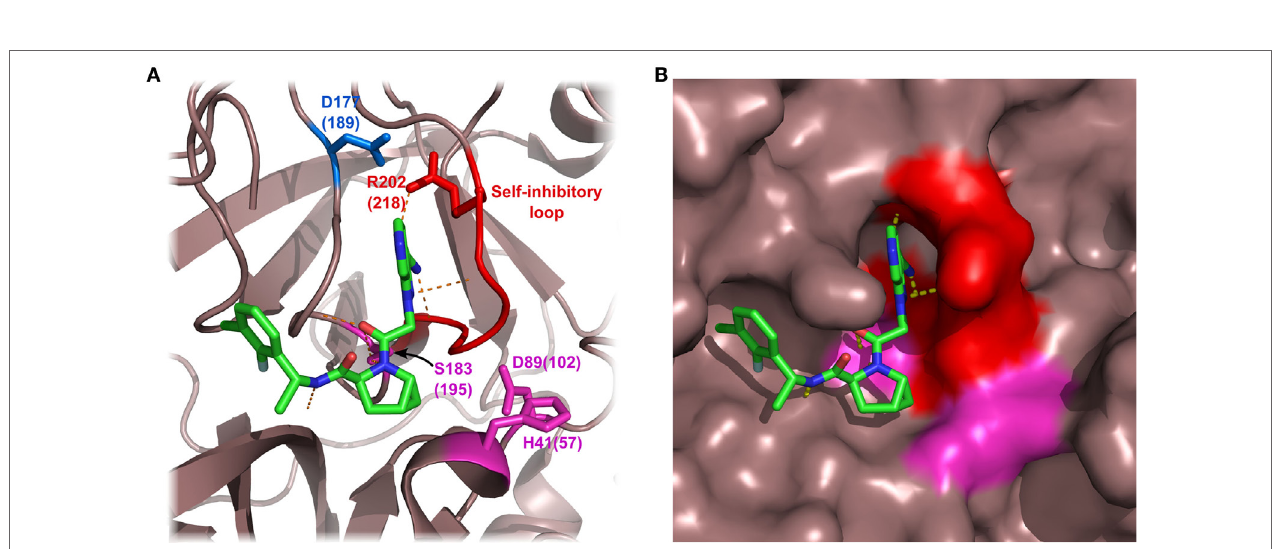
FiGURe 5 | Structure of factor D (FD) in complex with a selective small-molecule inhibitor. The figure is based on the structure of FD in complex with “inhibitor 6” described by Maibaum et al. (120) (PDB entry 5FCK). Inhibitor 6 has multiple polar and hydrophobic interactions with the protein body. It is notable that inhibitor 6 interacts with the self-inhibited conformation of FD, probably stabilizing FD in this form. Asp 177 (blue) of the S1 pocket forms a salt bridge with Arg 202 of the self-inhibitory loop (red). The catalytic triad is colored magenta. Numbers indicate amino acid positions in mature FD, while numbers in parenthesis reflect the traditional chymotrypsinogen numbering. Hydrogen bonds are indicated by yellow dashed lines. (A) FD shown by ribbon representation. (B) FD shown by surface representation.